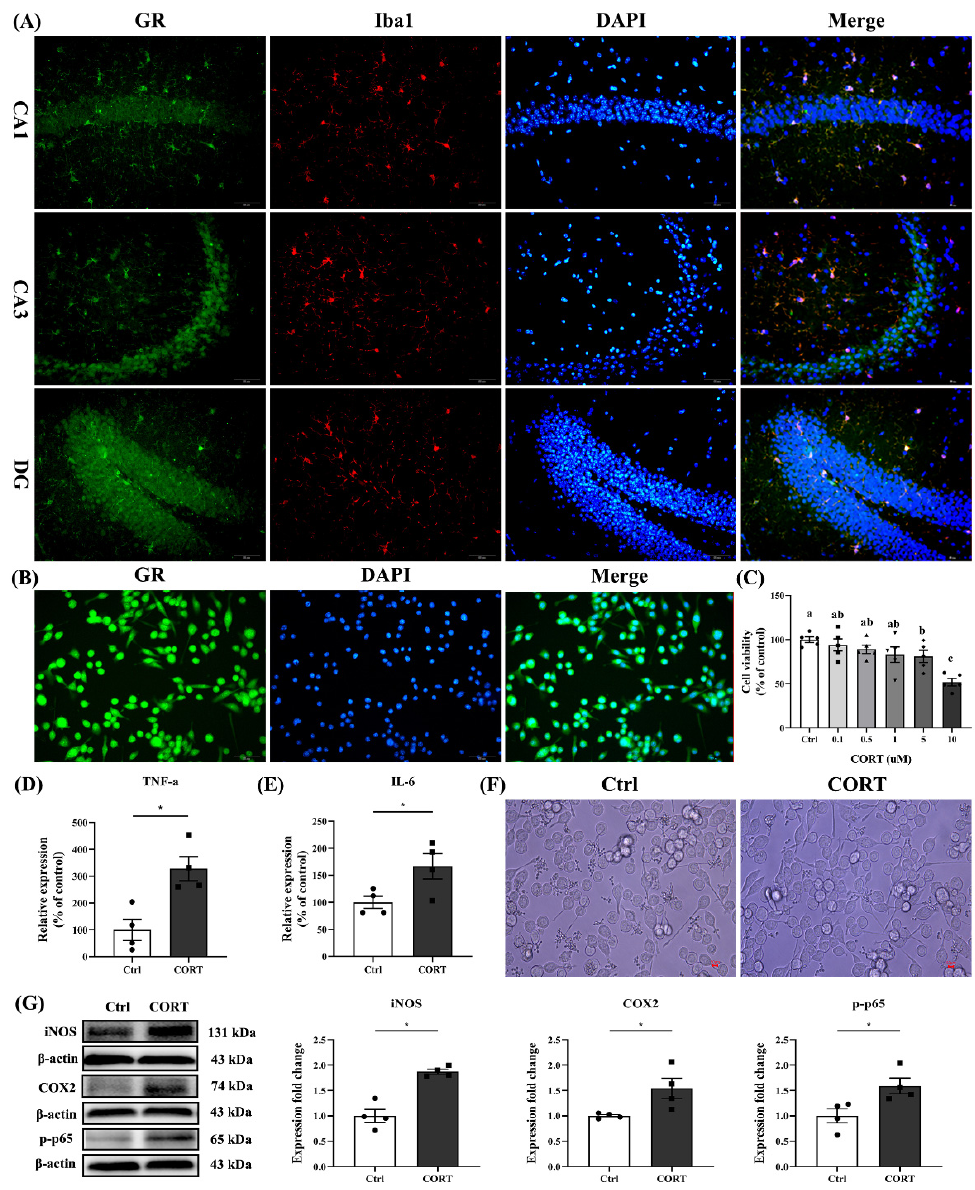
Figure 6. Corticosterone-induced activation of microglia. ( A ) Immunofluorescence of GR in the hippocampus of mice. Iba1 marked microglia; GR marked glucocorticoid receptor; DAPI marked nuclei, respectively. Bar = 50 µ m. ( B ) Immunofluorescence of GR in the BV2 cells. Bar = 50 µ m. ( C ) Determination of the effect of CORT in BV-2 cells using MTT assay. BV-2 cell treated with CORT with indicated concentrations ( n = 6). ( D ) TNF- α detected in the supernatant of BV-2 cells ( n = 4). ( E ) IL-6 detected in the supernatant of BV-2 cells ( n = 4). ( F ) Effects of CORT intervention on microglia morphology. ( G ) Protein expression levels of iNOS, COX2 and p-p65 detected by immunoblotting in BV-2 cells ( n = 4). Differences were assessed using t-tests. The result represents the mean ± standard error of the mean. Values not sharing a common superscript letter (a,b,c) or marking (*) differ significantly at p < 0.05; those with the same letter (a,b,c) do not differ significantly ( p ≥ 0.05). Ctrl: control group, CORT: BV-2 cells treated with CORT (10 µ M)